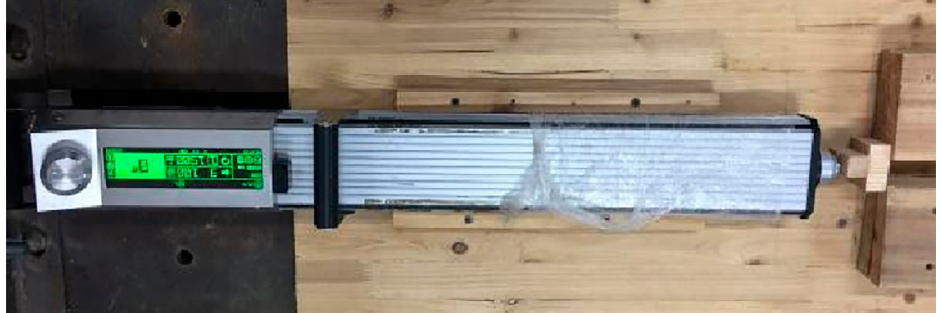
Figure 5. Micro-drilling resistance instrument IML PD400. When doing a micro-drilling resistance test of the columns, the columns should be divided into two categories. For the same inspecting section of the columns that are completely exposed to the outside, select three different drilling directions separated by an angle of 120 ◦ from each other (Figure 6a). For the columns that are half exposed, one or two directions are selected according to the specific situation (Figure 6b). For the same column, take the 5 cm distance from the ground as the first testing section. If damage is detected, continue detecting by moving the same scheme upward by 5 cm or 10 cm until no damage is detected. The beam detection method refers to the column detection method. The condition of the timber structure at the beam-column joints needs attention, and the inspection is usually carried out at the angle of 45 ◦ between the beam-column joint (Figure 6c). Currently the resistographic analysis is used to investigate the internal decay of timber structures, based on the evaluation of the resistance profile during the needle perforations. The registration of resistance profiles permits also to quote the decay, based on the percent of soundness or decay in it.